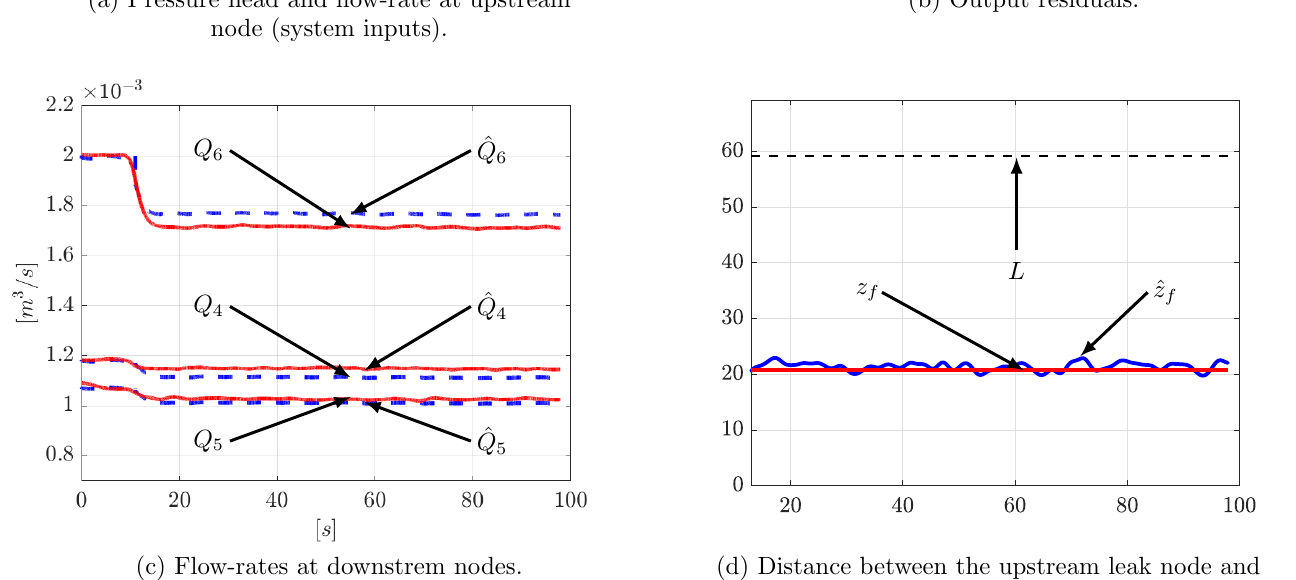
Figure 16. Experiment 5: leak induced in valve 5: ( a ) Pressure head and flow rate at upstream, ( b ) Output residuals, ( c ) Flow rate at downstream nodes and, ( d ) Leak